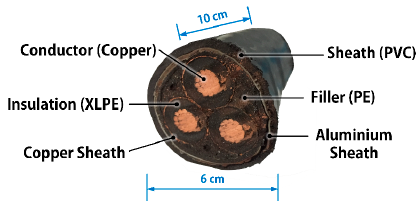
Figure 3. Cross-section of the ZRC-YJV-8.7 / 10 3 × 95 mm 2 power